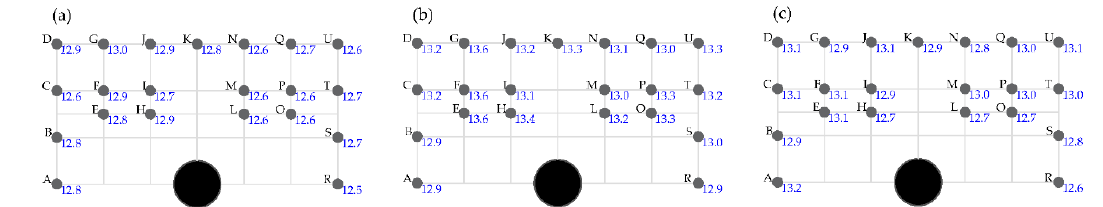
Figure 3. Local water levels within the study area for ( a ) Run 1, ( b ) Run 2, and ( c ) Run 3.